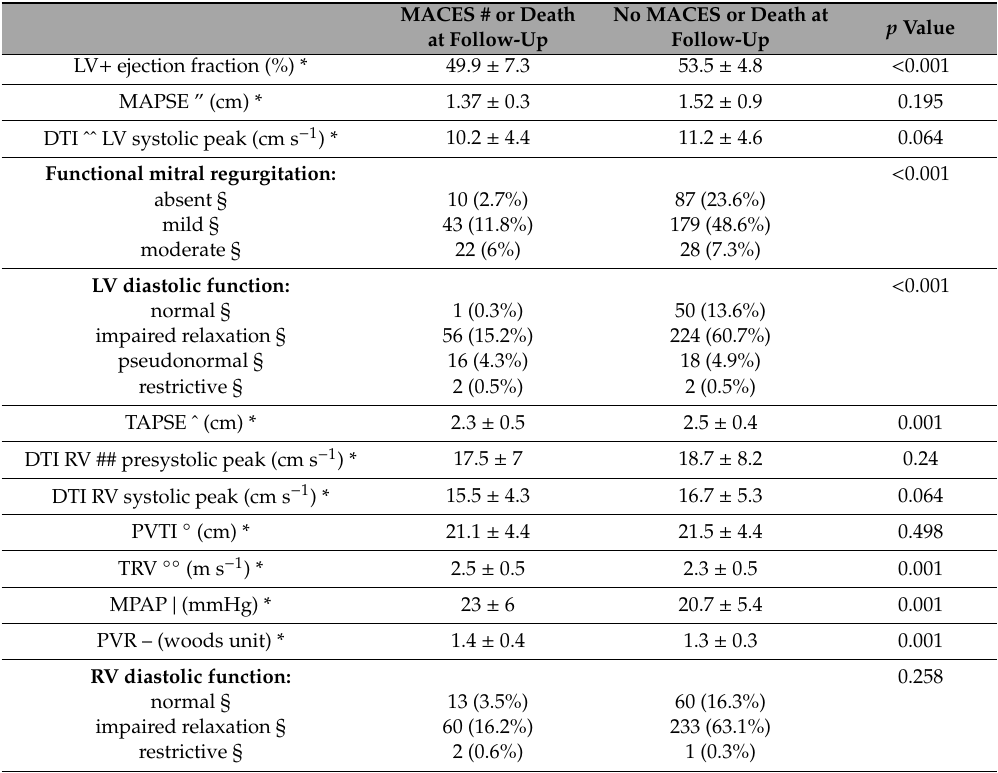
Table 3. Results of bivariate analysis.